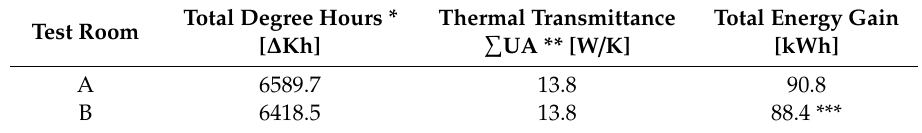
Table 1. Total energy gains from the surrounding building into the test rooms when T e < 19.0 ◦ C.